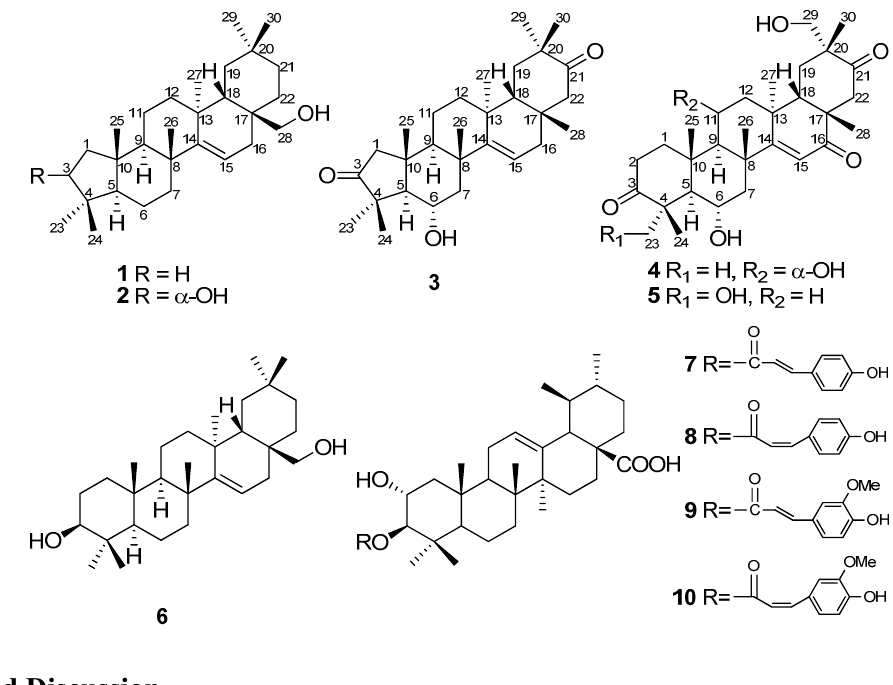
Figure 1. Chemical structures of compounds isolated from the branch barks of Davidia involucrata